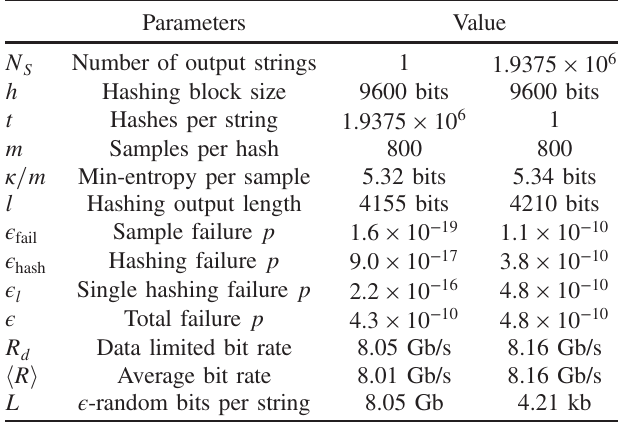
TABLE I. Parameters and associated values for the two real- time random number extraction scenarios implemented